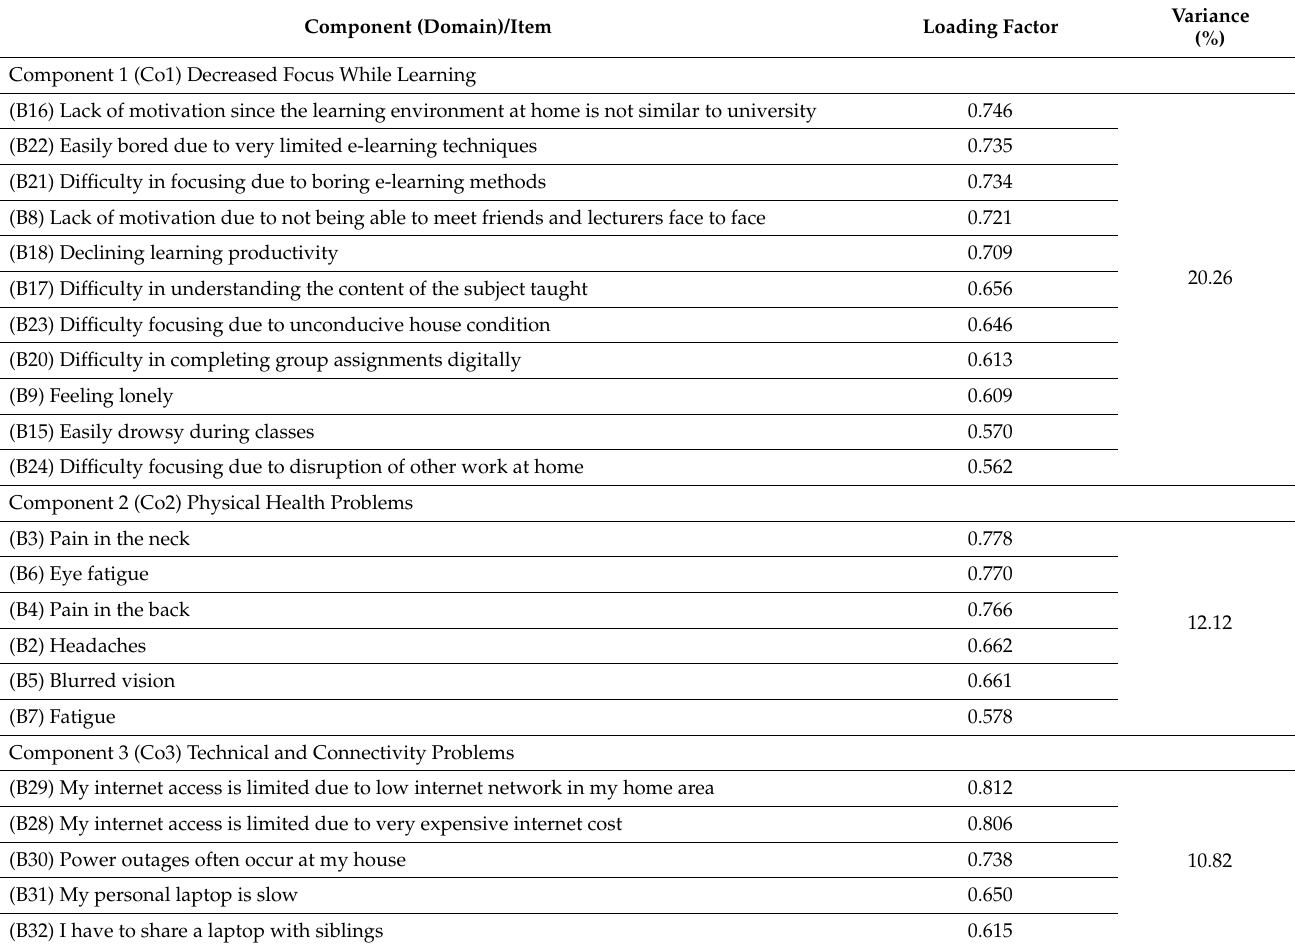
Table 3. Analysis Results of Main Component